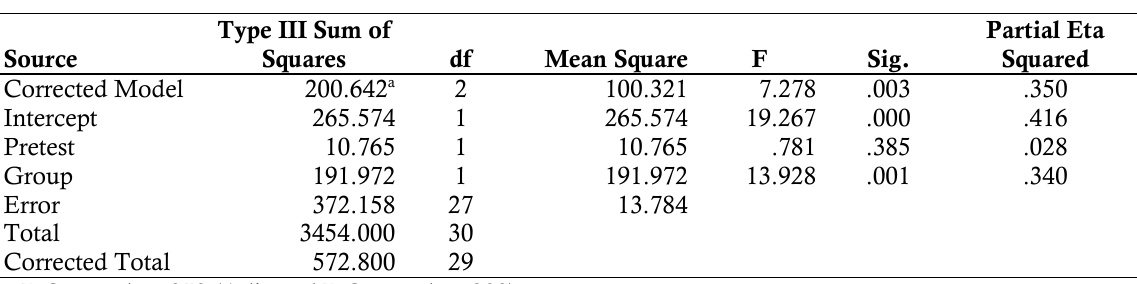
Partial Eta Squared